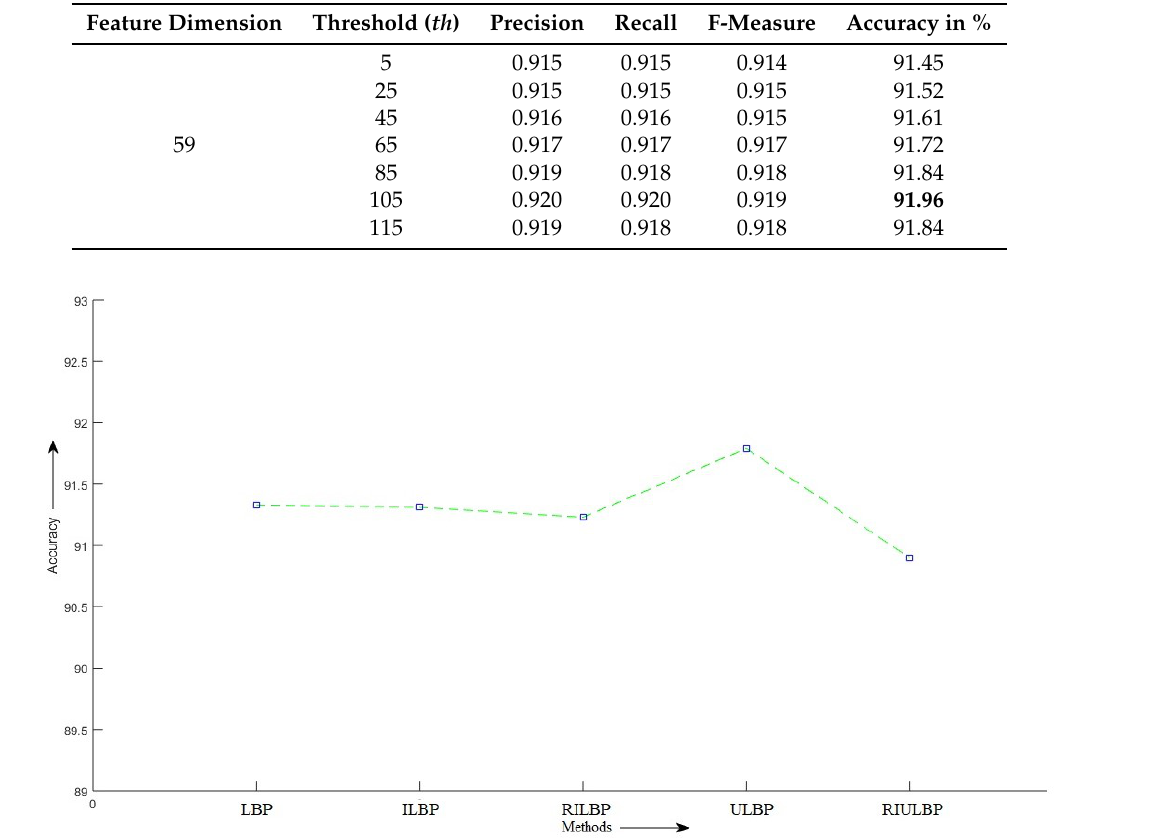
Figure 10. Graphical comparison of the performances of different LBP variants in classifying the texts and non-texts present in handwritten document images.